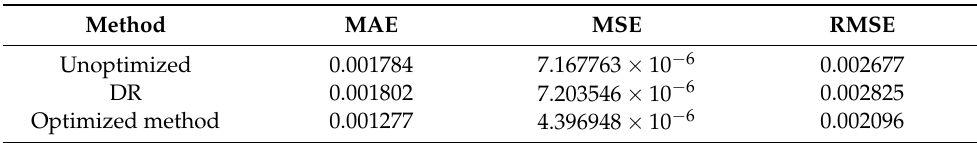
Figure 13. Identification result of AUV attitude angle. Table 5. Error comparison of different methods.